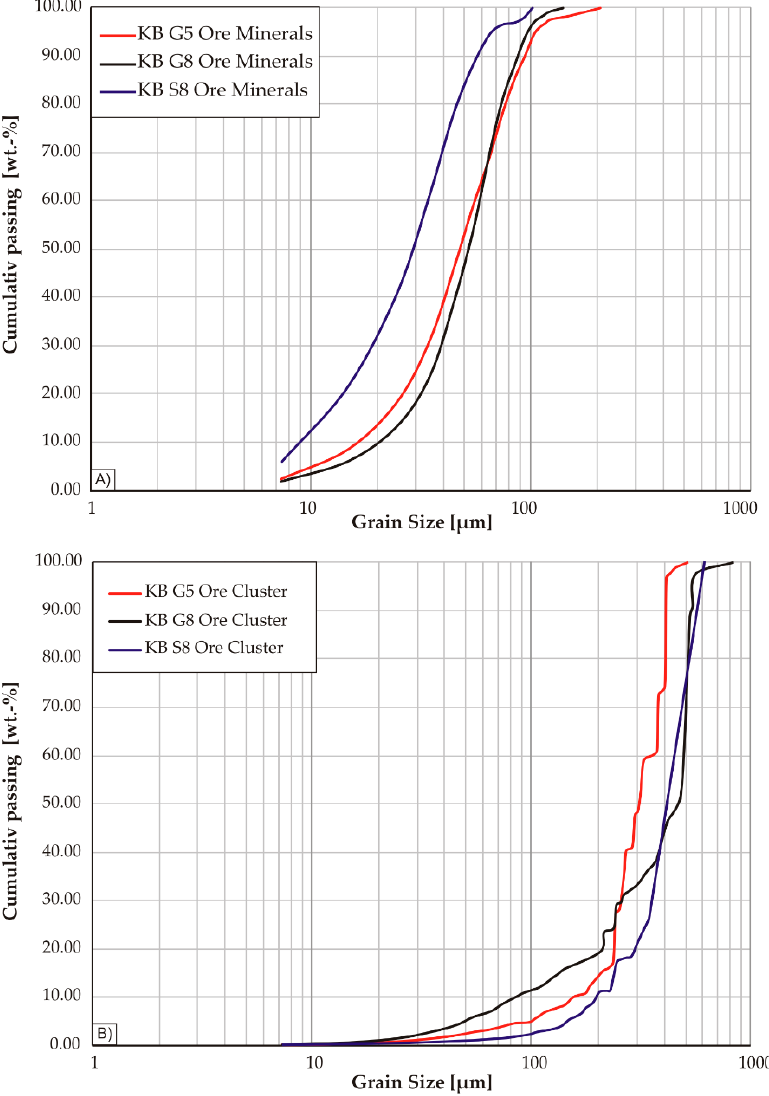
Figure 9. Particle size distributions of ore minerals ( A ) and ore clusters ( B ). The ore mineral groups Zr-silicates and REE-carbonates were combined into the class of ore minerals because these minerals are mostly observed in cluster assemblage. As can be obtained from the particle size distribution, the ore mineral size at P80 is significantly smaller (45–85 µm) in comparison to the particle size of the ore clusters (400–500 µm).